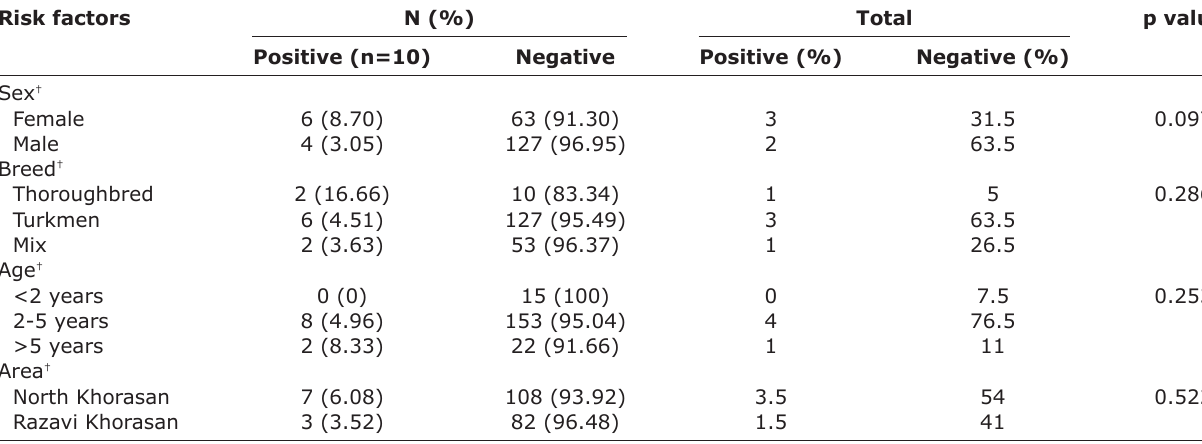
Table-1: Risk factors for SBV in 200 horses. Risk